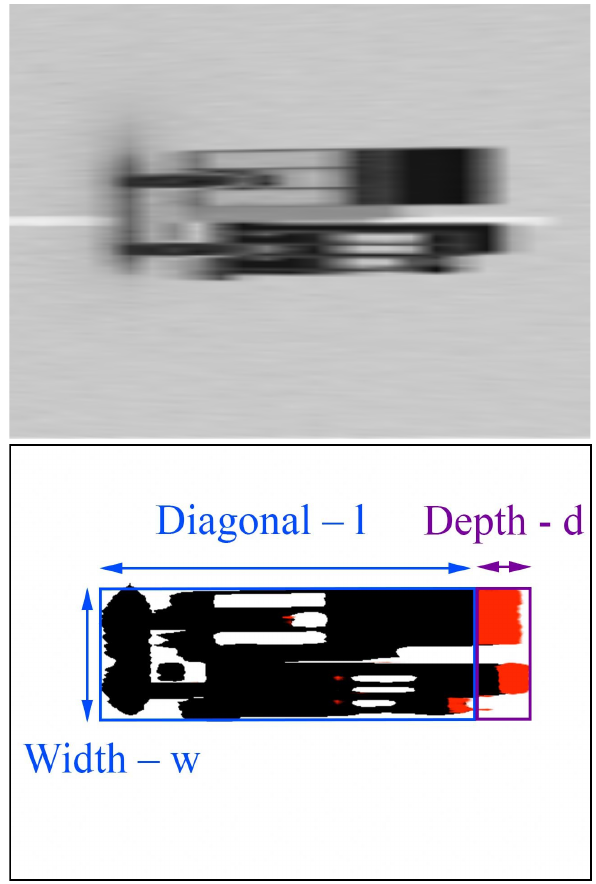
Figure 9. (a, upper) Fragment of the original orthophoto centered on the foreign object. (b, lower) Binarization of the orthophoto. Bright region visible on the difference of orthophotos is shown with red. ! The position of the foreign object in the runway coordinate system is also found using the orthophoto. The bottom left point of the foreign object rectangle defines the origin point of the foreign object coordinate system. The rotation of the main axes of the foreign object rectangle gives the rotation of the foreign object coordinate system around the Z-axis.